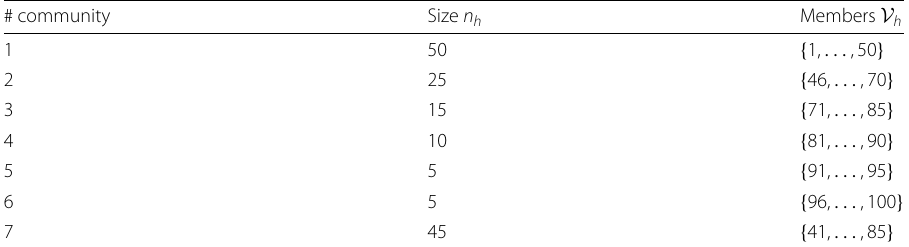
Table 4 Benchmark with overlapping community